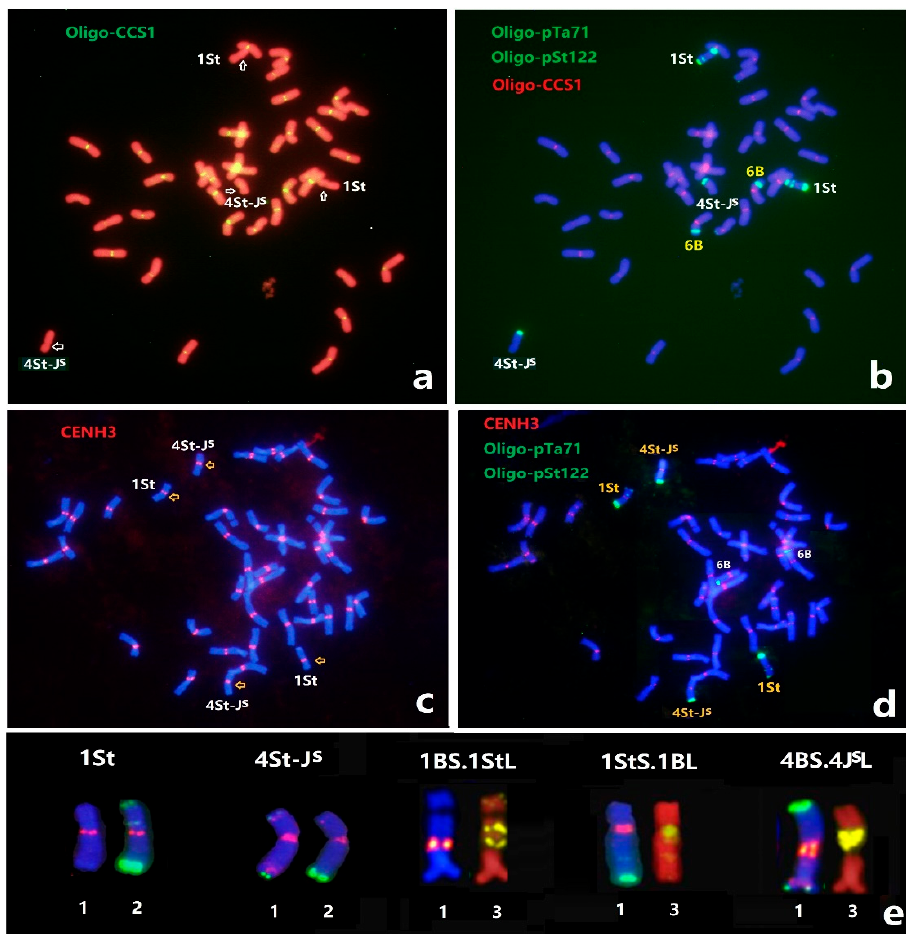
Figure 5. The centromeric repeats Oligo-CCS1 and anti-CENH3 location in X479 and derived translocations from immunostaining with the anti-CENH3 antibody and sequential ND-FISH. Sequential FISH of X479 by ( a ) Oligo-CCS1 and ( b ) Oligo-pTa71, Oligo-St122 and Oligo-CCS1. The arrows indicate the absent signals of Oligo-CCS1 in 1St and 4St-J S chromosomes. ( c ) Sequential immunostaining of anti-CENH3 and ( d ) ND-FISH of X479 by Oligo-pTa71 and Oligo-pSt122. The arrows indicate the CENH3 signals presented in 1St and 4St-J S chromosomes. ( e ) The FISH and anti-CENH3 signals for wheat-1St and wheat-4J S L translocation. The numbers 1–3 represent the combinations of Oligo-pSc119.2 with Oligo-pTa535 and CENH3, Oligo-pTa71 with Oligo-pSt122, and Oligo-(GAA) 7 ,